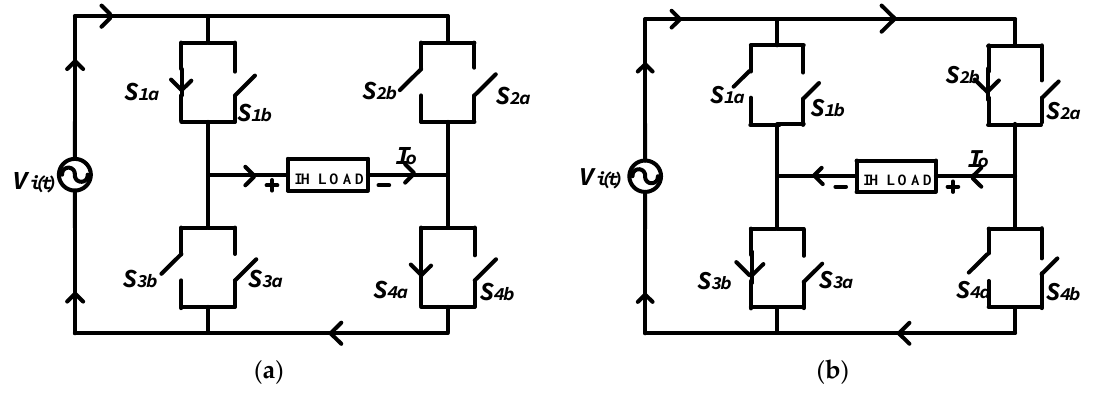
Figure 5. Positive mode of operation ( a ) Mode 1 and ( b ) Mode 2.